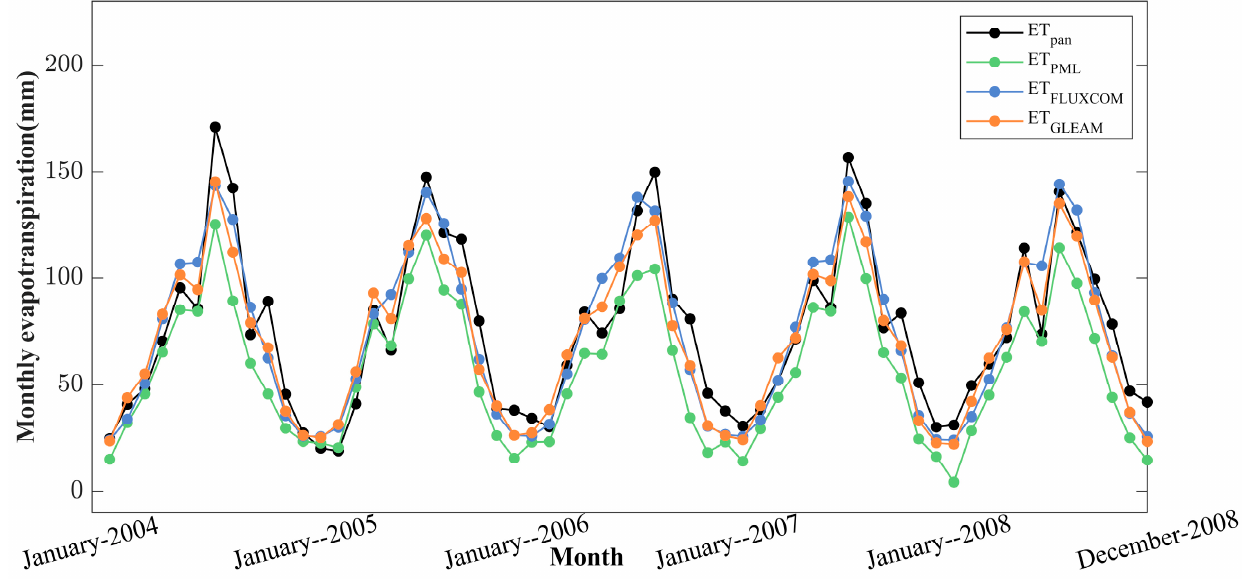
Figure 4. Temporal comparison of monthly ET between remote sensing-based datasets with in situ observations of pan